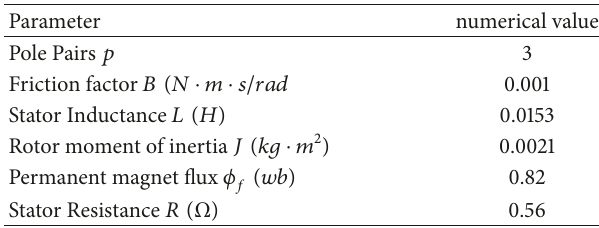
Table 1: The parameters of